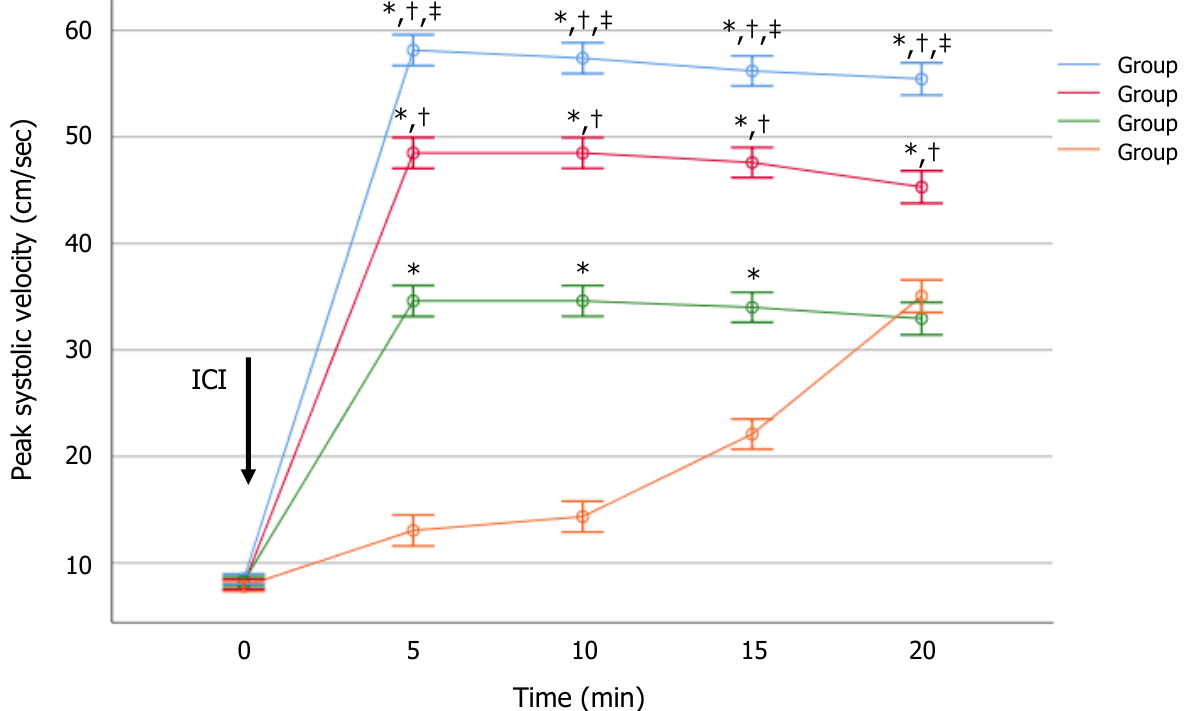
Figure 1. Effect of anxiety on the peak systolic velocity after intracavernous injection (ICI) of alprostadil at serial times of assessment. The level of anxiety was assessed using the Generalized Anxiety Disorder (GAD-7) score. Values are expressed as mean ± standard error of the mean. * p < 0.01 vs. Group 4; † p < 0.01 vs. Group 3; ‡ p < 0.01 vs. Group 2, analyzed using the multivariate analysis of variance (MANOVA), with LSD post-hoc